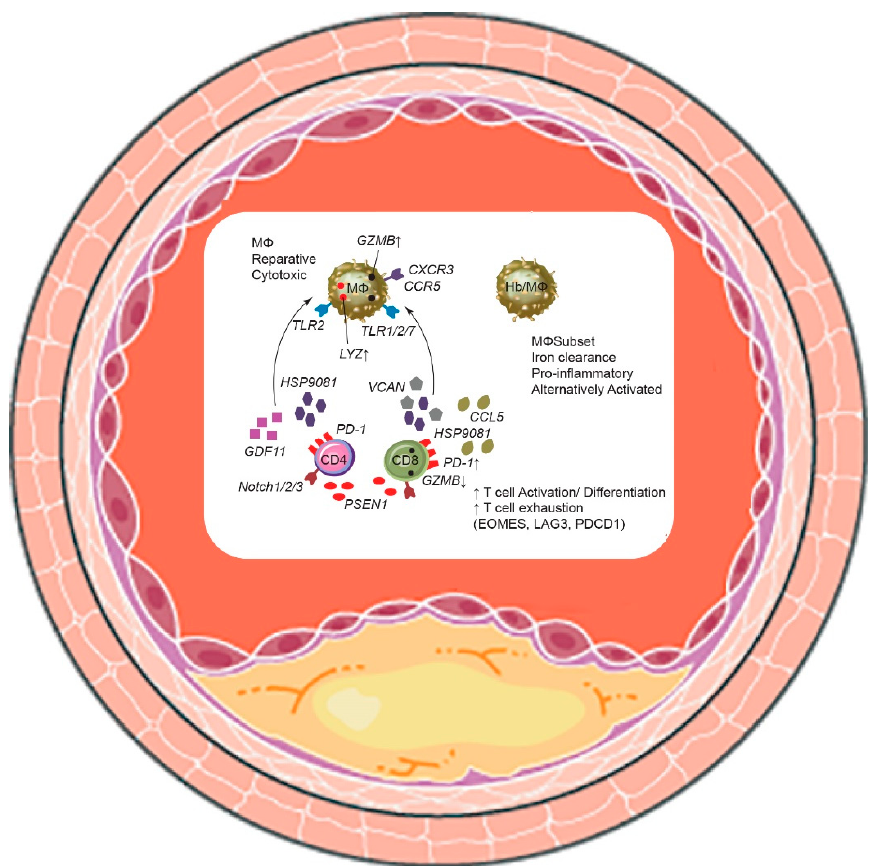
Figure 2. Immune cell–cell interactions of the human atherosclerotic plaque by single-cell omics. Main innate and adaptive immune cell to cell interactions in carotid plaques of symptomatic patients.